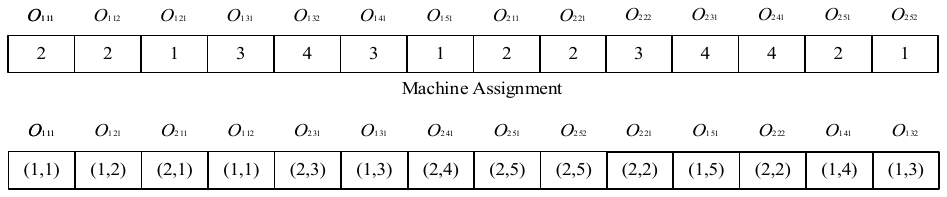
Figure 1. The tree-like structure of the products.